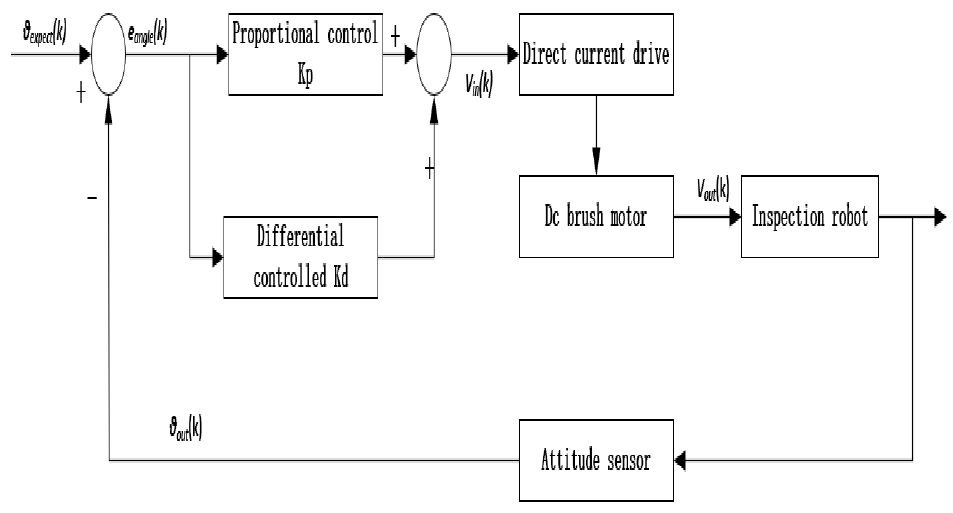
Figure 11. Upright ring control block diagram.